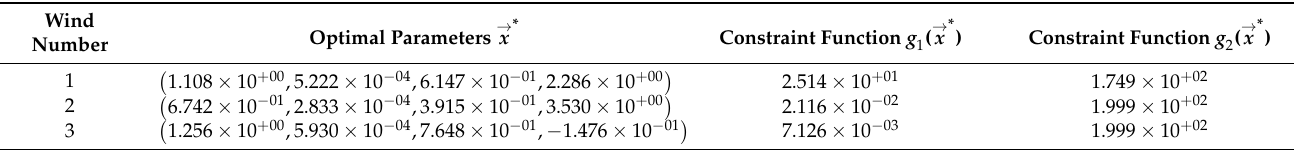
Table 2. The fitting curves of the #1, #2, and #3 wind turbines are shown in Figure 7. Table 2. The result of solving for the optimal